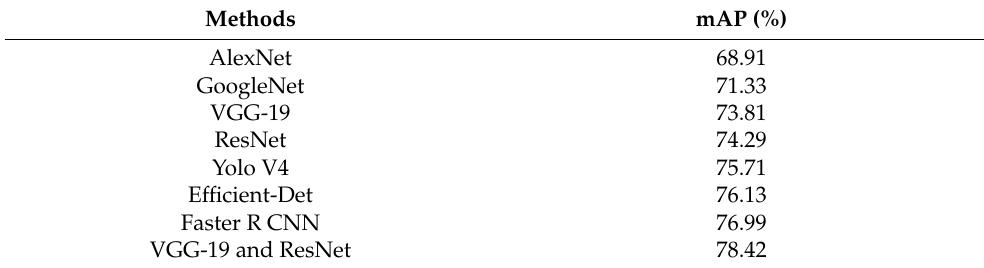
Figure 8. The mAP of deep learning techniques on DIOR dataset.